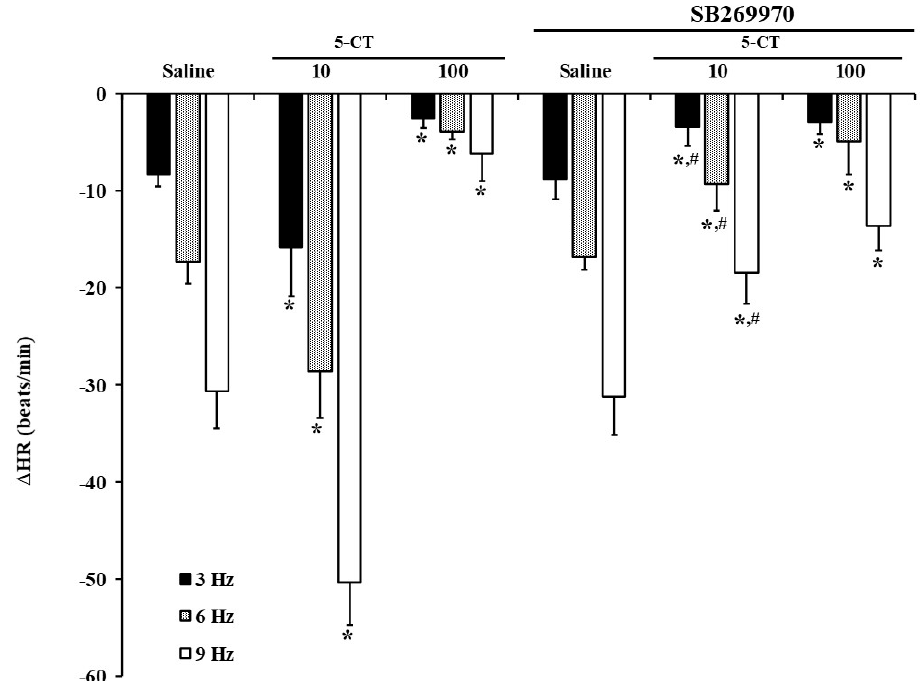
Figure 3. Effect of i.v. bolus of SB269970 in the saline- or 5-CT-influence on the electrically-induced bradycardic responses in fluoxetine-treated diabetic rats. Changes in decreases in heart rate ( ∆ HR) by electrical vagal stimulation after i.v. administration of bolus of saline (1 mL/kg) or 5-CT (10 and 100 µ g/kg) in the presence or absence of SB269970 (0.5 mg/kg. i.v.) in fluoxetine-treated diabetic pithed rats. * p < 0.05 versus respective saline. # p < 0.05 versus 5-CT 10 µ g/kg. I.V. administration of LY310762, a selective 5-HT 1D receptor antagonist, prior to 50 μ g/kg of L-694,247 completely blocked the inhibition of the vagally-induced bradycardia originated by this selective 5-HT 1D agonist in FT diabetic rats (Figure 4).